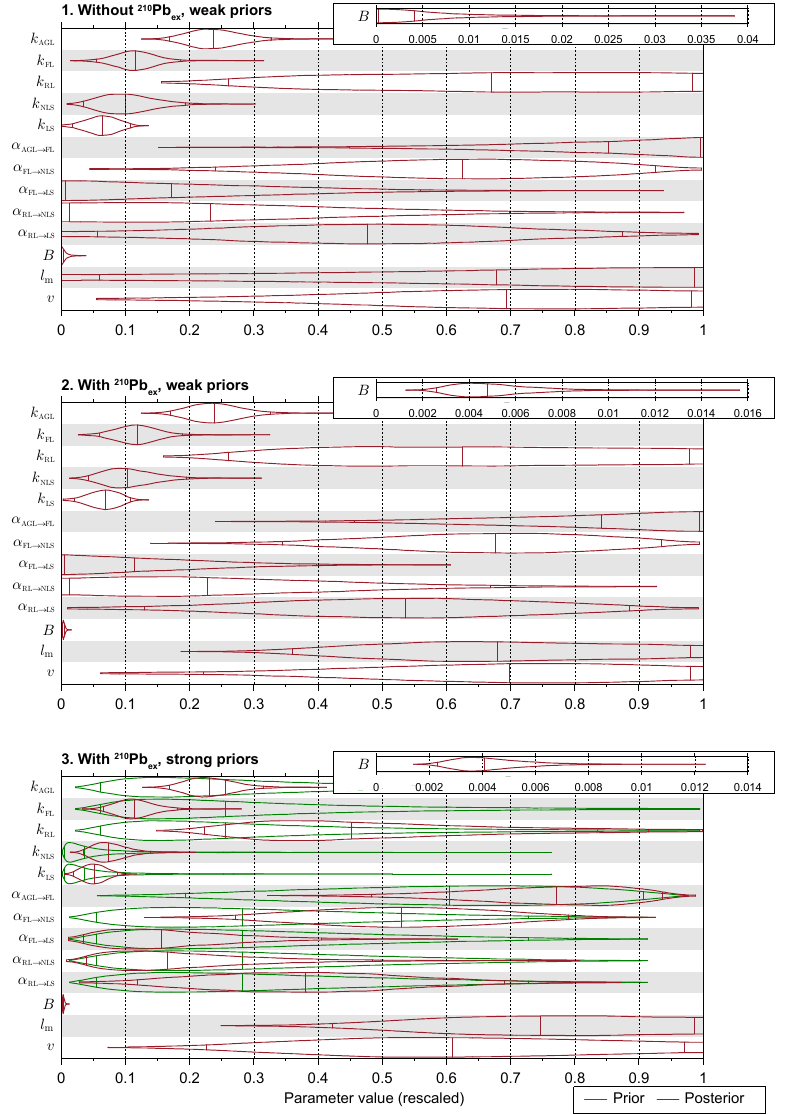
Fig. 4. Posterior distributions for the three setups for Loobos. The “violins” depict the marginal distribution for each parameter. The three vertical lines inside the violins indicate the median and the 95% confidence bounds. The parameters are normalized to the sampling ranges (see Table 2).